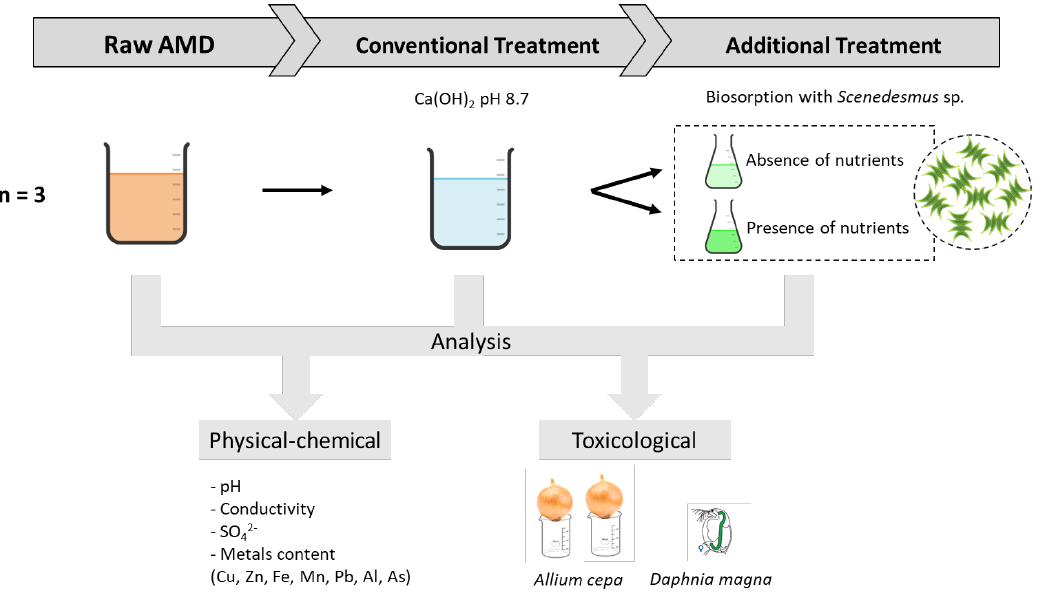
Figure 1. Illustrative scheme of this work, including the treatments and analysis performed.